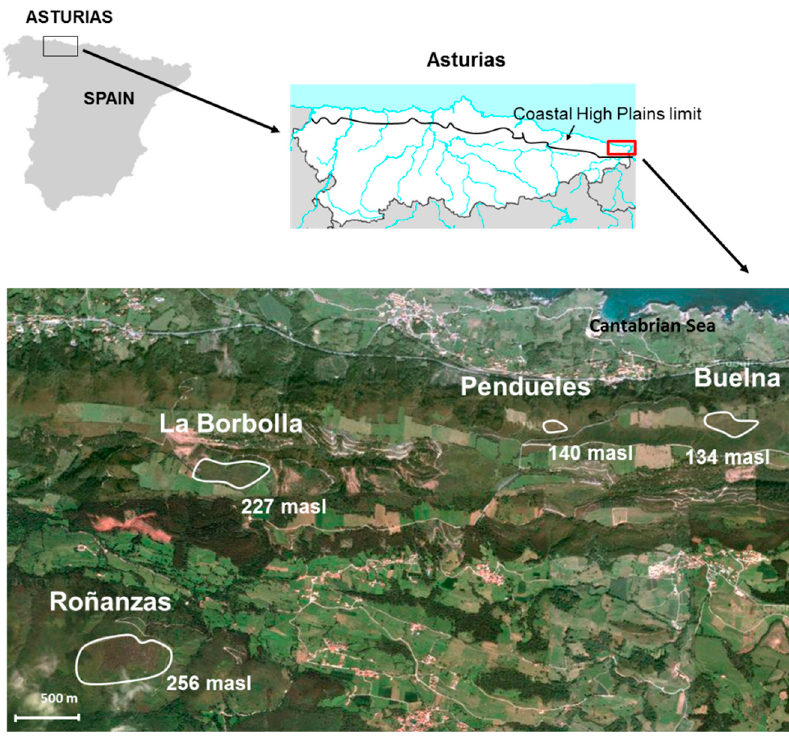
Figure 1. Location of the Roñanzas, La Borbolla, Buelna, and Pendueles mires.